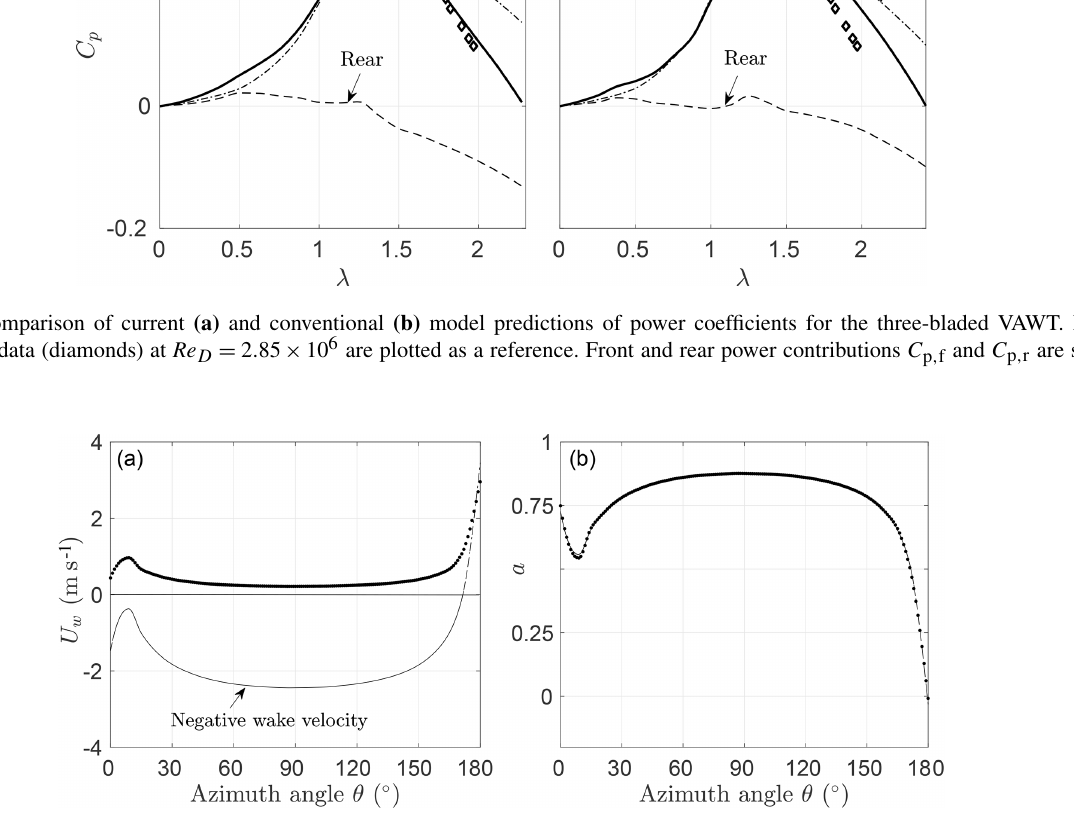
Figure 7. Front half-cycle wake velocity profile, U w (a) , and induction factor, a (b) , as a function of azimuth angle θ , for the three-bladed VAWT. Current model (points) and conventional model (solid line) at λ = 1 . 97. The induction factor distribution is almost identical for both DMST formulations, as it concerns the front half of the